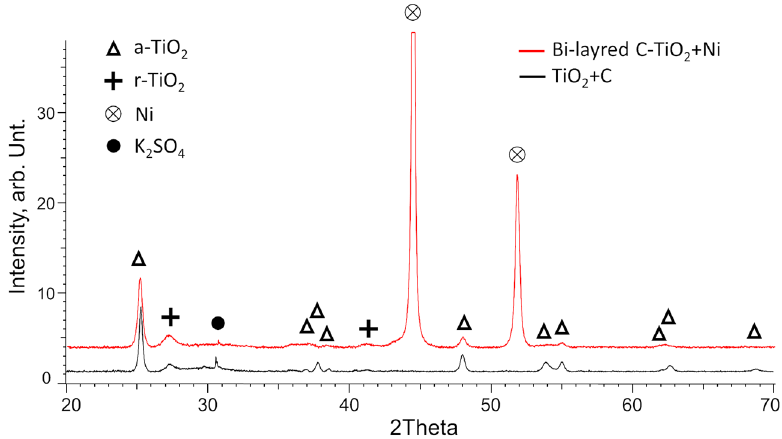
Figure 7. XRD data of the washed-off C-TiO 2 powder prepared without (black pattern) and with (red pattern) Ni underlayer. TiO 2 anatase (a-TiO 2 ), TiO 2 rutile (r-TiO 2 ), Ni and K 2 SO 4 phases were indexed according to the JCPDS database cards No. 21-1272, 21-1276, 01-078-07533 and 96-120-0013, respectively.